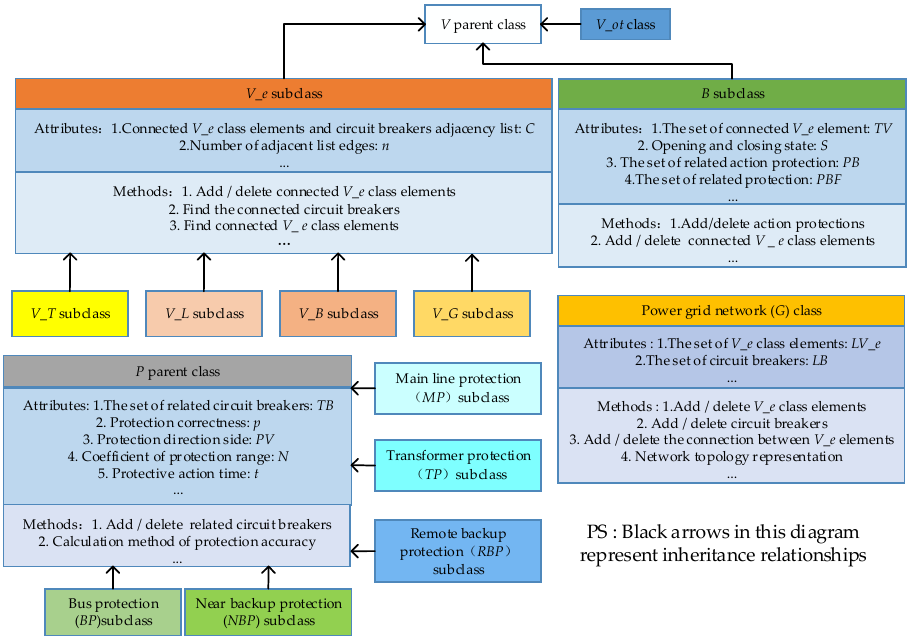
Figure 2. Definition of